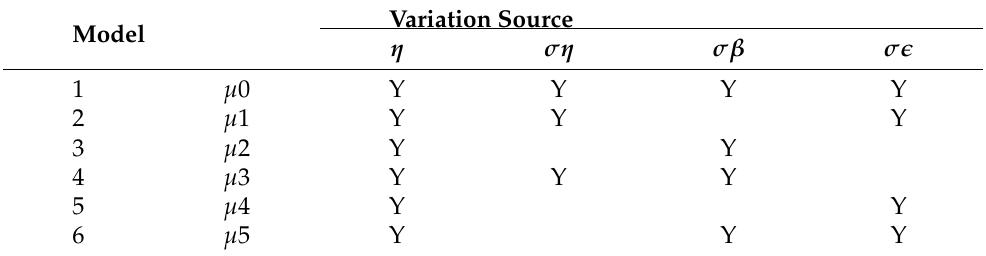
Table 3. Degradation models